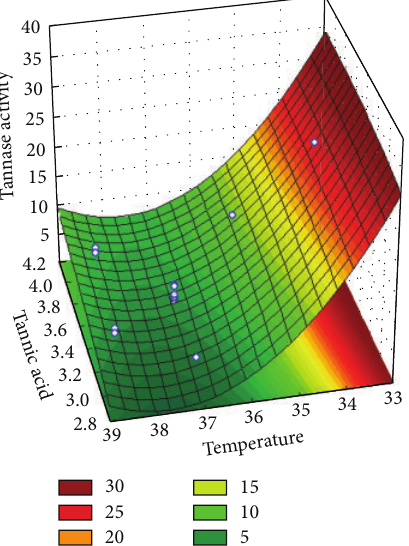
Figure 1: Response surface graph showing the effect to tannic acid and temperature interaction on tannase activity in SSF.